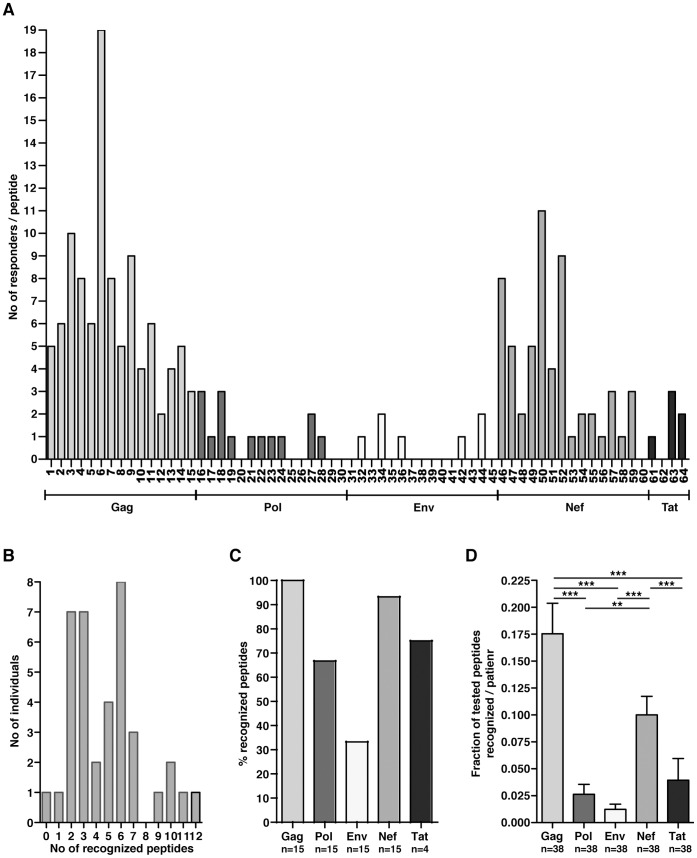
Immunodominance of predicted Gag- and Nef-specific CD4+ T cell responses.(A) Overall immunogenic analysis illustrating the individual peptides that generated a CD4+ T cell response. The vertical axis represents the total number of individuals that recognised each peptide, while the horizontal axis illustrates the individual peptide numbers within each HIV region. (B) Distribution of the number of recognised peptides per individual. (C) Percentage of peptides from different HIV proteins that induced a CD4+ T cell response. (D) Fraction of tested peptides from different HIV protein regions that generated CD4+ T cell responses per individual. The statistical analysis was performed with a one-way ANOVA and a non-parametric Kruskal Wallis test with Dunn’s multiple comparison test to compare all of the pairs of columns; *P<0.05, **P<0.01 and ***P<0.001. The data are derived from 38 independent experiments (mean and SEM).